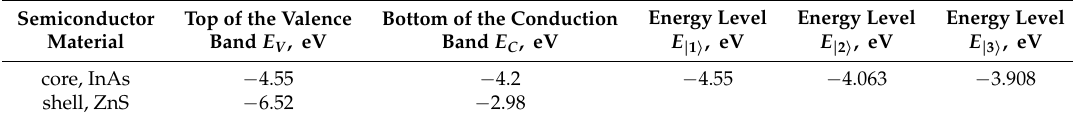
Table 4. The bands and energy levels positions in InAs/ZnS core–shell